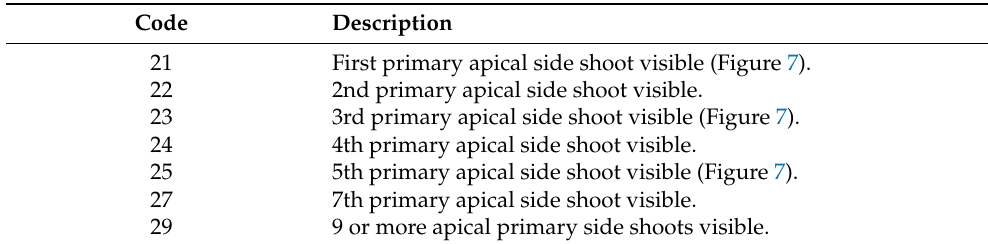
Table 3. Description of the principal stage 2 (formation of side shoots) of slender nightshade, based on the BBCH